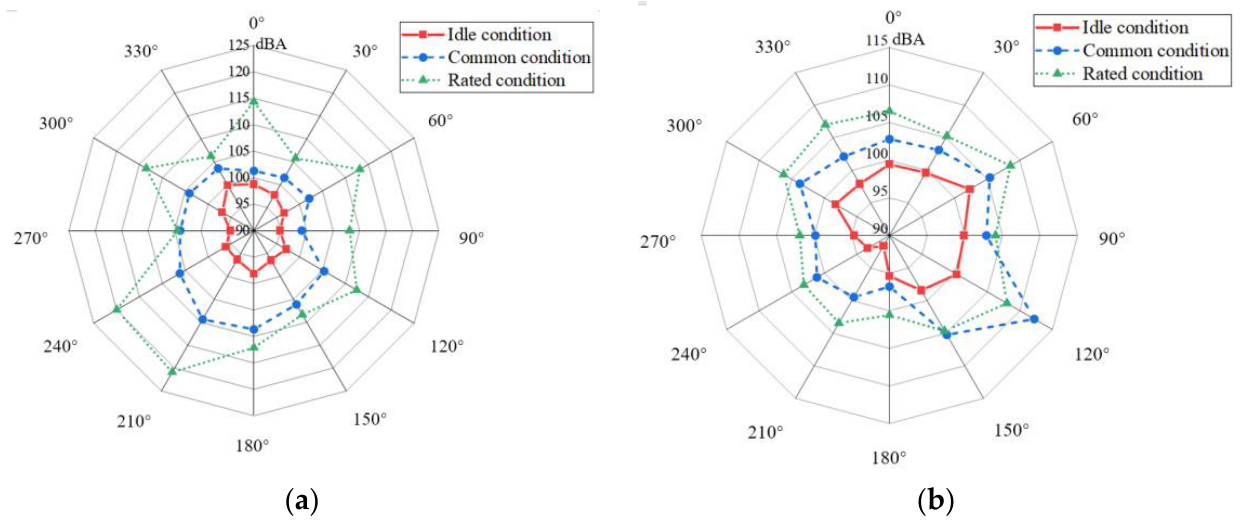
Figure 16. Noise radiation directivity of centrifugal impellers. ( a ) First stage. ( b ) Second stage.